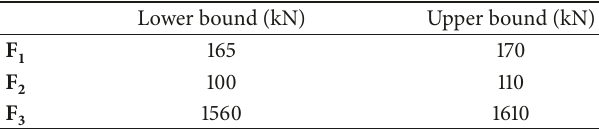
Table 1: Bounds of interval loads to automobile